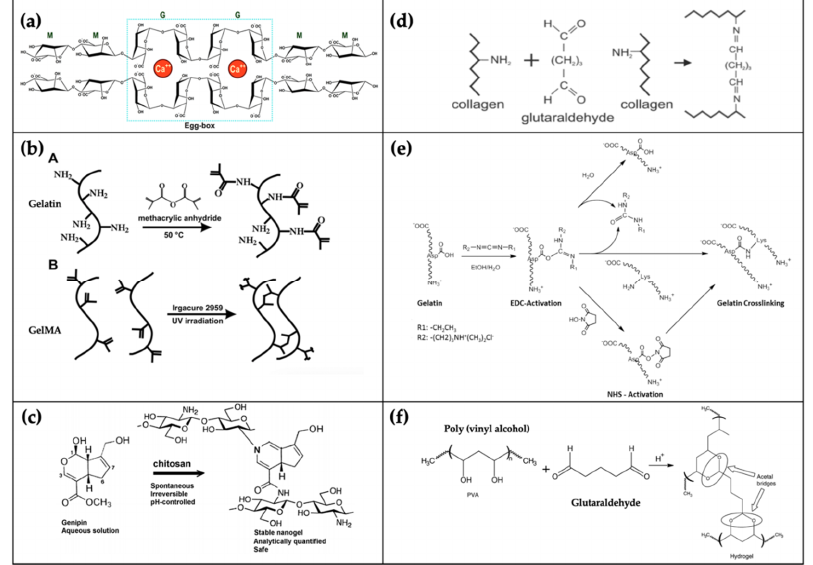
Figure 4. Crosslinking mechanisms of some instances. ( a ) alginate crosslinking with calcium ions (adapted from [134]); ( b ) synthesis gelatin methacrylamide (GelMA) and crosslinking with UV was adapted with permission from [65]. Copyright 2010 Elsevier; ( c ) chitosan crosslinking with genipin [135]; ( d ) collagen crosslinked with glutaraldehyde was adapted with permission from [136] Copyright 2018 Elsevier; ( e ) crosslinking mechanism of gelatin [137]; ( f ) PVA crosslinked with glutaraldehyde was adapted from [138]. Copyright 2008